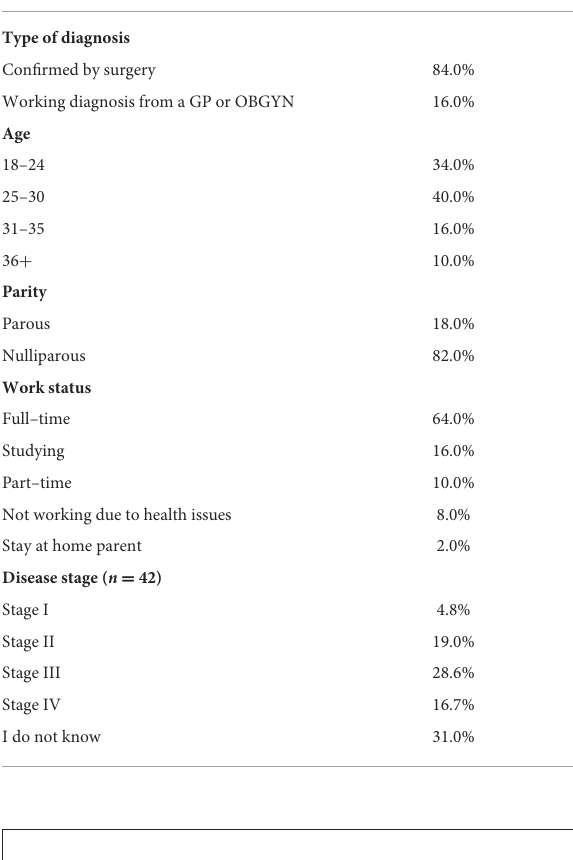
TABLE 1 Patient demographics in the study cohort.